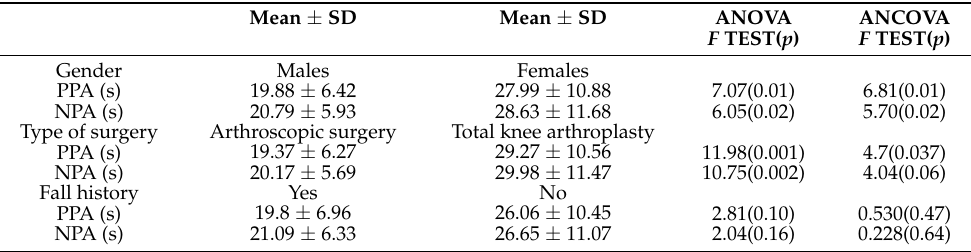
Table 3. Analysis of the differences in agility performances between groups based on gender, type of surgery and fall history.